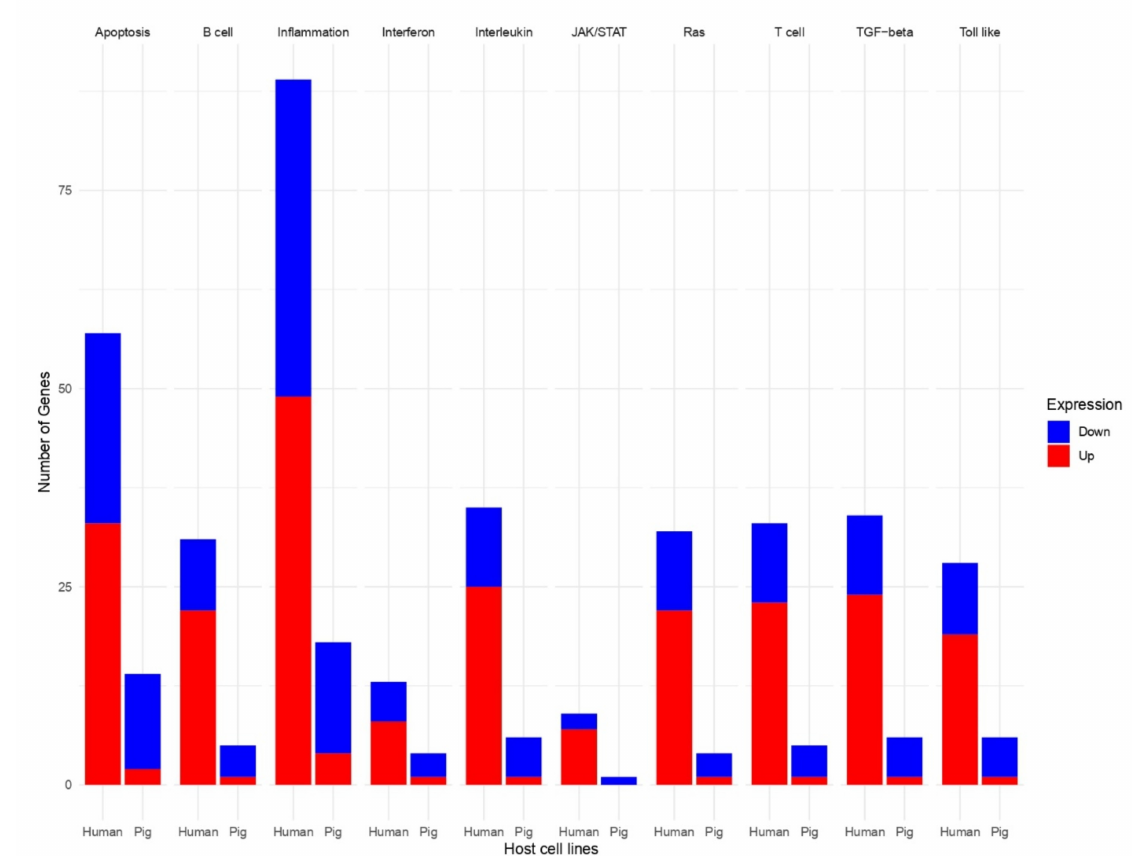
Figure 6. DEGs in 10 common immune-response-associated pathways in pigs and humans during PDCoV infection. Results are shown in 10 pathways: apoptosis signaling pathway, B-cell activation, inflammation/cytokine signaling pathway, interferon signaling pathway, interleukin signaling pathway, JAK-STAT signaling pathway, Ras signaling pathway, T-cell activation, TGF- β signaling pathway, and toll-like receptor signaling pathway. Blue, down-regulated; red,